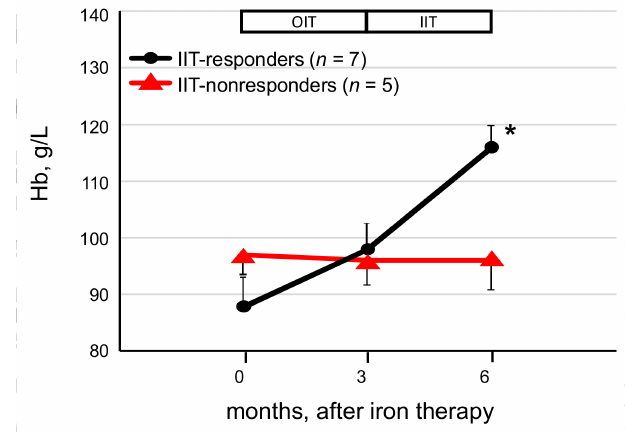
Figure 3. Change of Hb levels in IIT group before and after IIT. Of the 12 OIT-nonresponders, the levels of Hb were significantly increased in seven (58.3%) of the 12 patients at the end of the study, whereas the Hb levels remained unchanged in the five IIT-nonresponders. Data are expressed as mean ± SEM. Comparison of two nonparametric data groups was analyzed by the Mann–Whitney U test. * p < 0.01, vs. IIT-nonresponders.